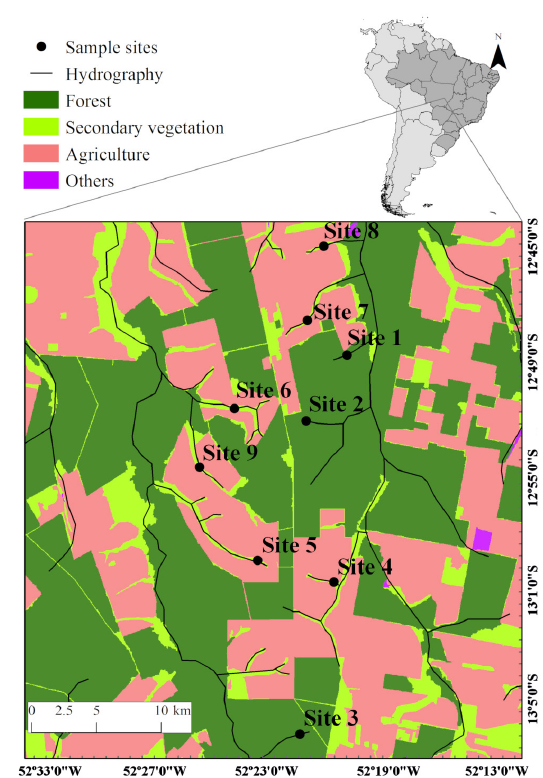
FIGURE 1 | Location of the nine streams sampled in the dry season of 2017, Tanguro Farm, state of Mato Grosso,